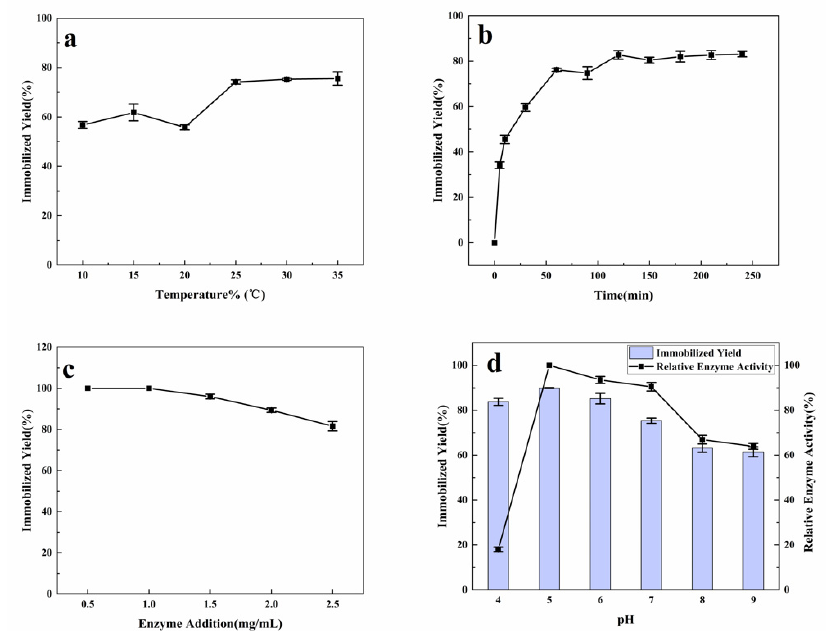
Figure 1. The effect of enzyme immobilization process under different immobilization conditions of ( a ) temperature, the reaction took 1 h ( b ) time, the reaction temperature was 25 °C, ( c ) enzyme concentration, and ( d ) pH.